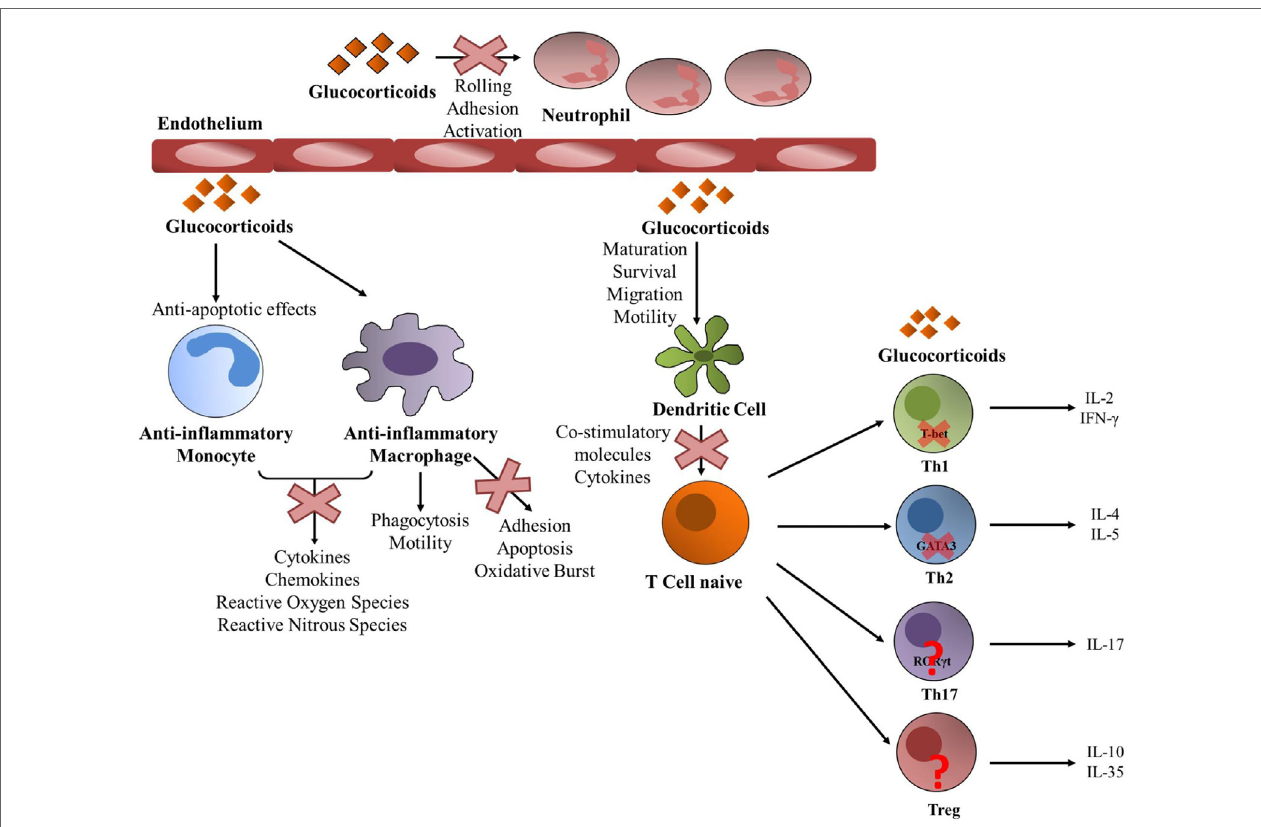
FiGURe 2 | Glucocorticoid (GC) activity on periphery immune cells. GCs act upon almost every immune cell type. GCs promote an anti-inflammatory state on both monocytes and macrophages. GCs prevent monocytes into entering apoptosis and inhibit the liberation of pro-inflammatory mediators by both types of cells. Particularly in macrophages, GCs promote phagocytosis and motility, while they inhibit adhesion, apoptosis and oxidative burst. They also act upon neutrophils function by inhibiting rolling, adhesion and activation. GCs act toward dendritic cells by promoting their maturation, survival, migration and motility, and at the same time GCs inhibit their ability to activate T cells by suppressing the production of pro-inflammatory molecules. A naïve helper T (Th) cell can differentiate into different Th lineages and GCs exert different actions. They act upon Th1 by decreasing T-bet transcriptional activity and suppressing the production of pro-inflammatory molecules such as IL-2 and IFN γ . They also suppress GATA3 activity in Th2 cells inhibiting the expression of IL-4 and IL-5. The action of GCs toward Th17 and regulatory T cells is not yet well